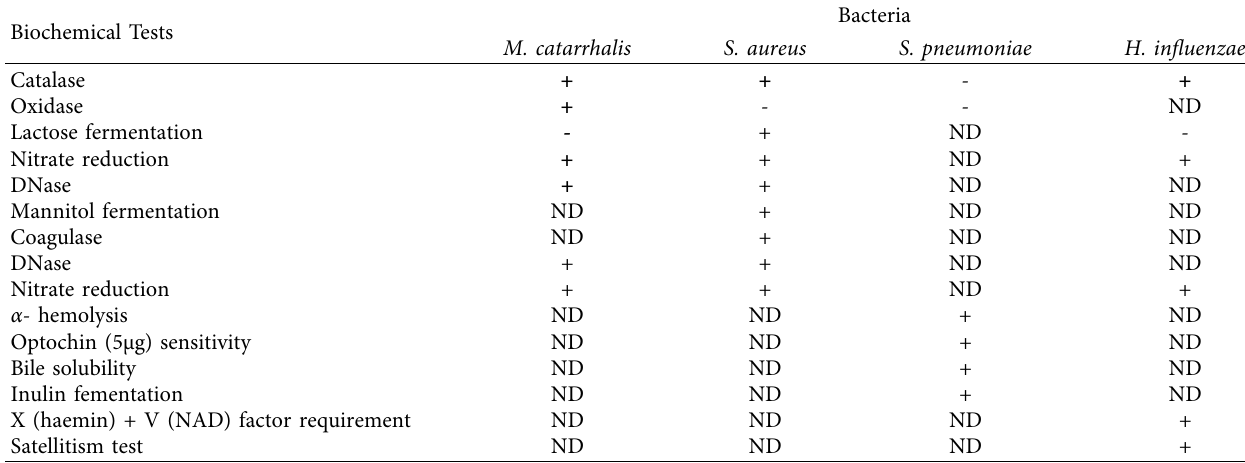
Table 1: Biochemical properties of isolated